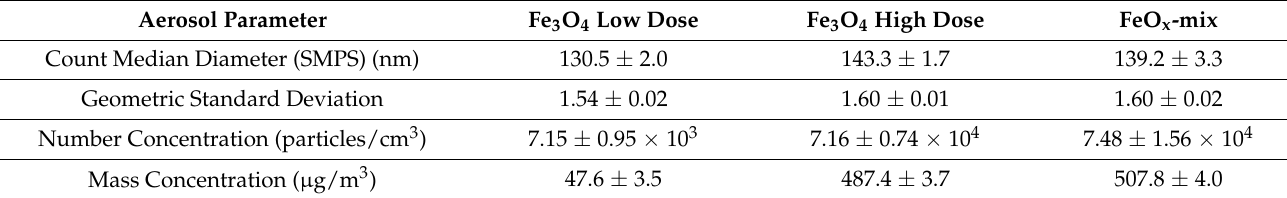
Figure 4. Aerosol characterisation. Number-weighted mobility equivalent particle size distributions averaged over the entire exposure duration for each aerosol exposure group ( A ). Error bars are not shown for clarity. Representative TEM images of the aerosol particles ( B ) delivered to the Fe 3 O 4 high-dose (a,b) and FeO x -mix high-dose (c,d) exposure groups. The scale bars are as follows: (a) 50 nm; (c) 100 nm; (b) and (d) 5 nm. Table 2. Measured aerosol